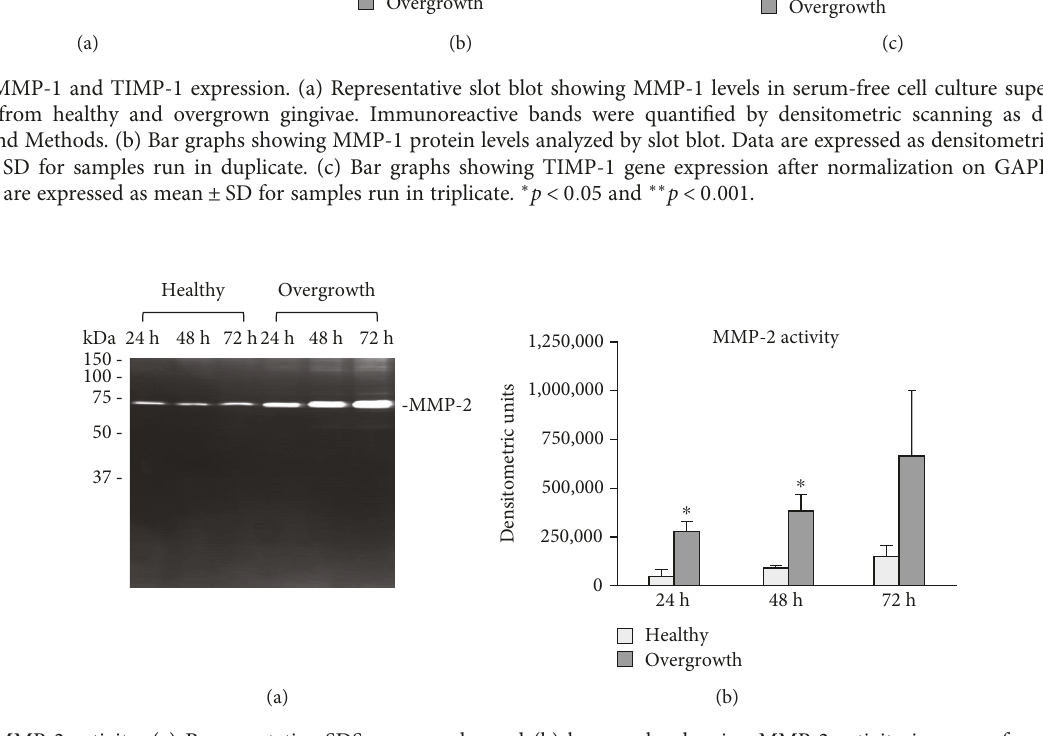
Figure 7: MMP-2 activity. (a) Representative SDS-zymography and (b) bar graphs showing MMP-2 activity in serum-free cell culture supernatants of fi broblasts from healthy and overgrown gingivae after densitometric analysis of immunoreactive and lytic bands. Data are expressed as densitometric units and are mean ± SD for samples run in duplicate. ∗ p < 0 05